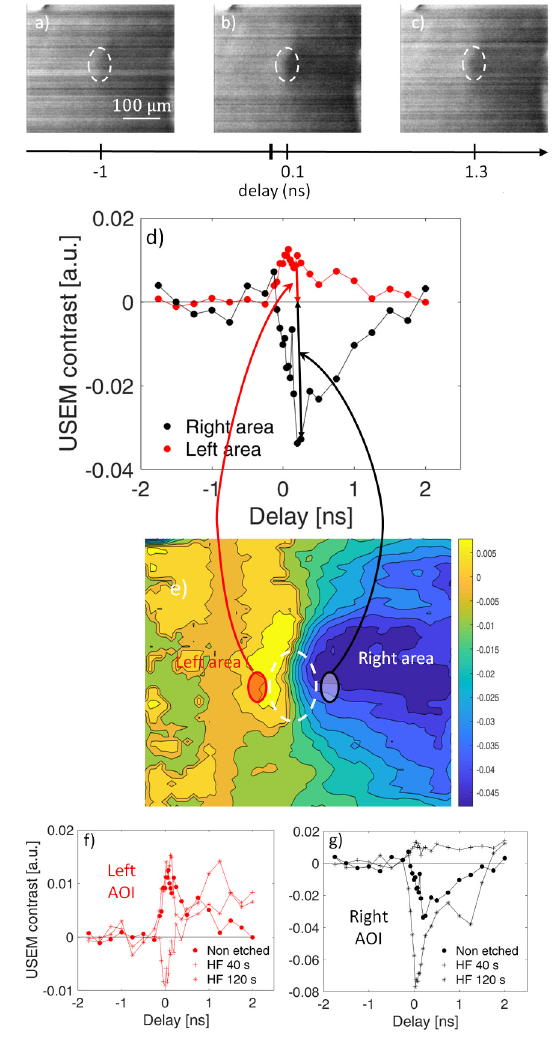
Fig. 1. Time evolution of USEM photoinduced contrast on highly p -doped Si, as a function of pump-probe delay. (a)-(c): 2D USEM contrast maps on a non-HF etched sample at three delay times, highlighting the bipolarity in sign of the contrast. (d) Time series of the USEM contrast, from the two AOI at left (red) and right (black) side of the laser spot (white), shown on the 2D USEM contrast step map in panel (e). (f): comparison of the SE contrast amplitude induced in differently HF treated samples in the left AOI; (g) the same for the right